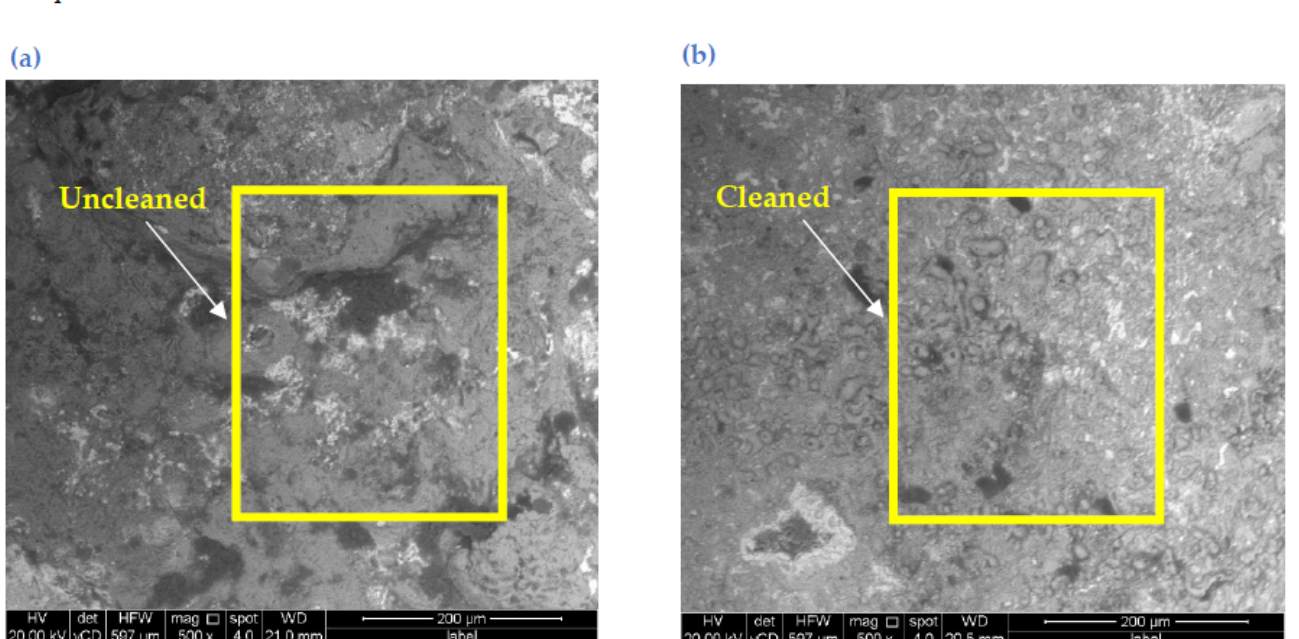
Figure 11. SEM image of sample C ( a ) before and ( b ) after cleaning at 500× magnification.